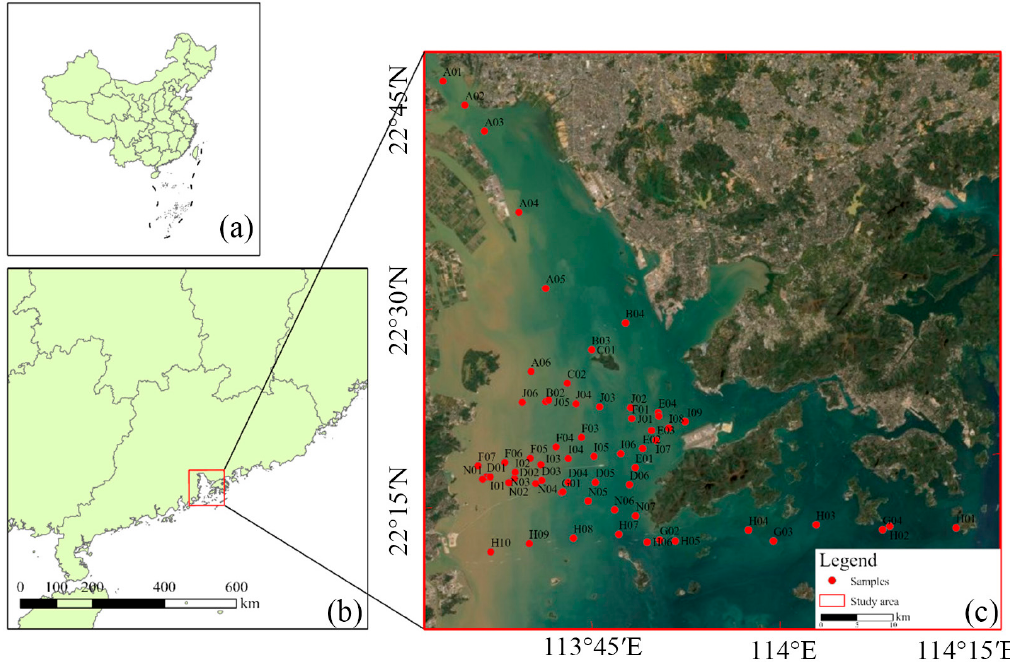
Figure 1. The Pearl River estuary location in the context of China ( a ) and part of South China ( b ). The in-situ survey stations are marked in red dots in the PRE ( c ).